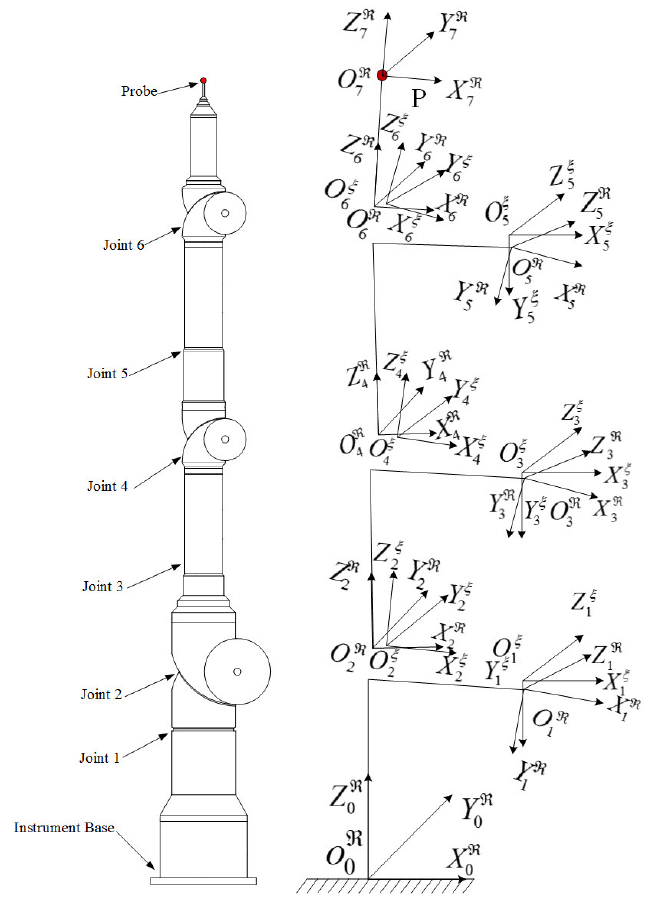
Figure 3. Configuration of portable articulated coordinate measuring machine (PACMM) based on the generalized geometric error